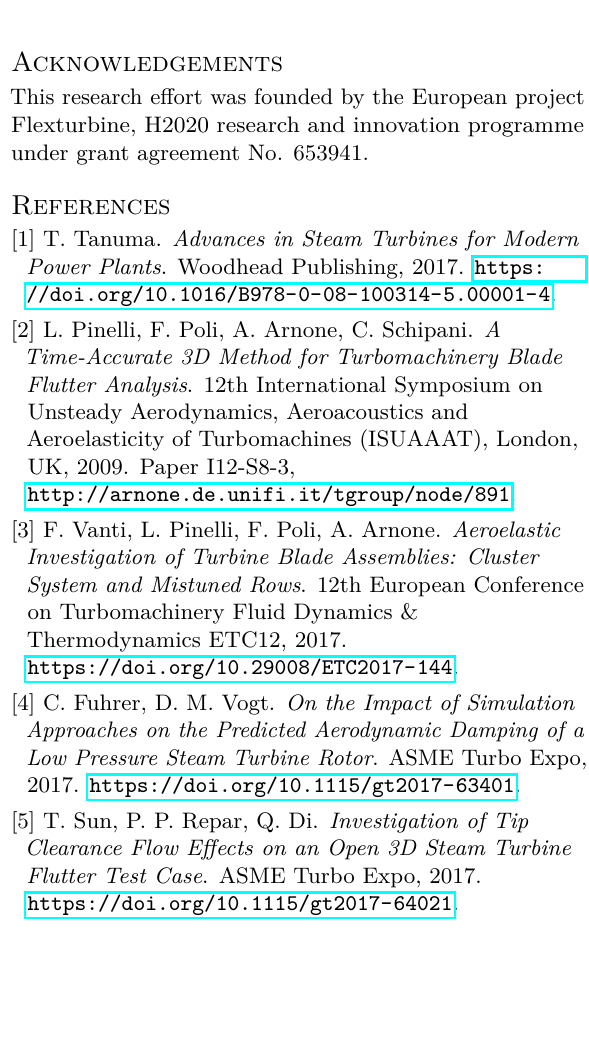
Figure 22. Aerodynamic work of blade torsion mo- tion - blade #6: experimental (EXP), CFX and TRAF